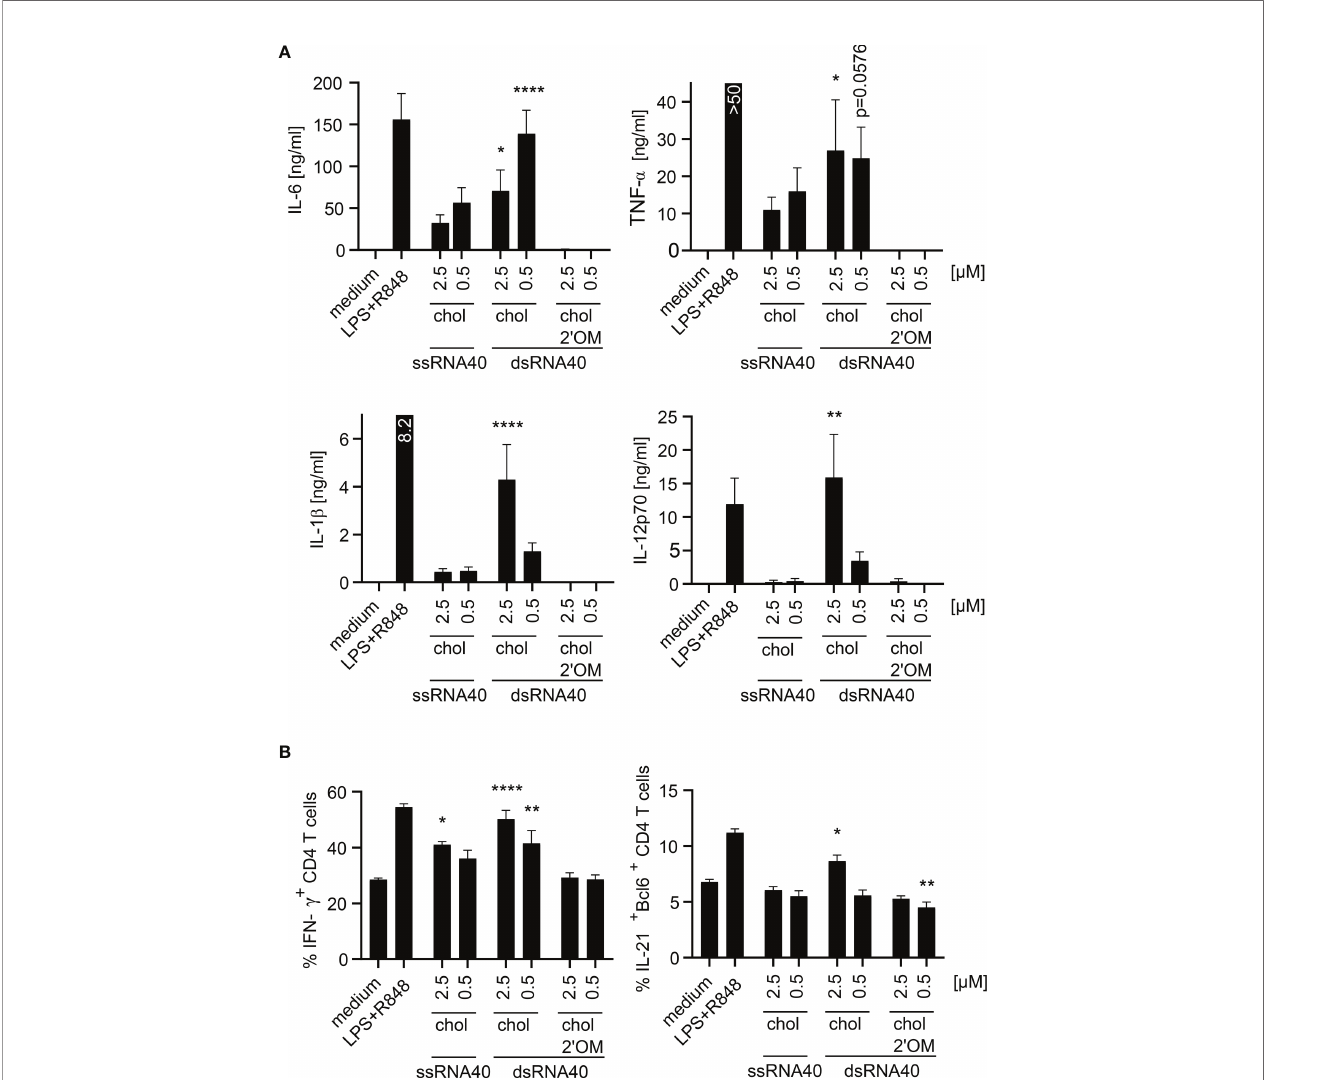
FIGURE 5 | dsRNA40-chol nanoparticles induce proin fl ammatory cytokines in puri fi ed human monocytes and promotes T H1 and T FH cell responses. (A) Puri fi ed human monocytes were stimulated with ssRNA40-chol, dsRNA40-chol and dsRNA40-chol-2 ’ OM at 2.5 µM and 0.5 µM. Medium and LPS (1 µg/ml) in combination with R848 (2.5 µg/ml) served as controls. Supernatants were harvested after 20 h of incubation and cytokine induction was analyzed by ELISA. Data were calculated from six individual donors. Bars indicate mean + SEM. *p < 0.05, **p < 0.01, ****p < 0.0001; one-way ANOVA with Dunnett ’ s post-hoc test. (B) Puri fi ed human CD4 + T cells were restimulated with anti-CD3 and anti-CD28 and incubated with conditioned monocyte supernatant [monocytes were stimulated as described in (A) ]. Cells were incubated for fi ve days before they were analyzed by fl ow cytometry. Data were calculated from four individual donors. Bars indicate mean + SEM. *p < 0.05, **p < 0.01, ****p < 0.0001; one-way ANOVA with Dunnett ’ s post-hoc